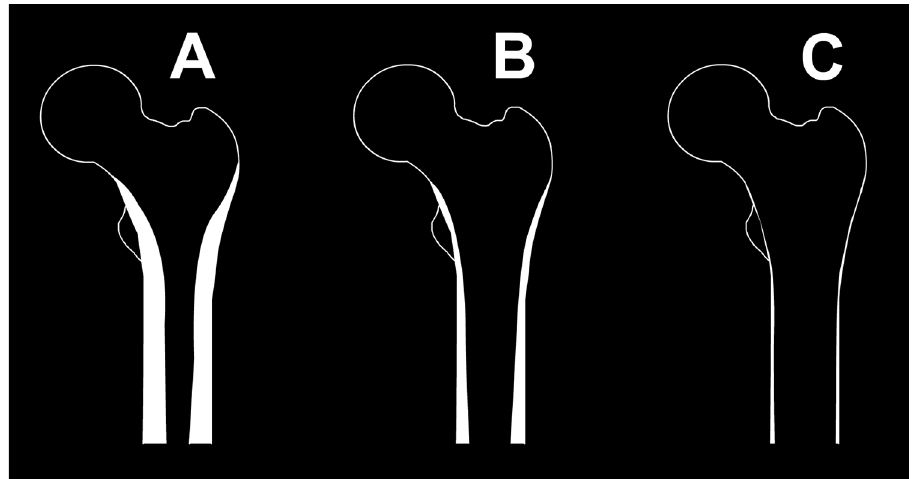
Figure 2. Dorr femur types. Dorr ( A ) represents a femur with thick cortices and narrow canal. Dorr ( B ) represents a femur with thinner cortices and a wider canal. Dorr ( C ) represents a femur with thin cortices and a wide femoral canal.